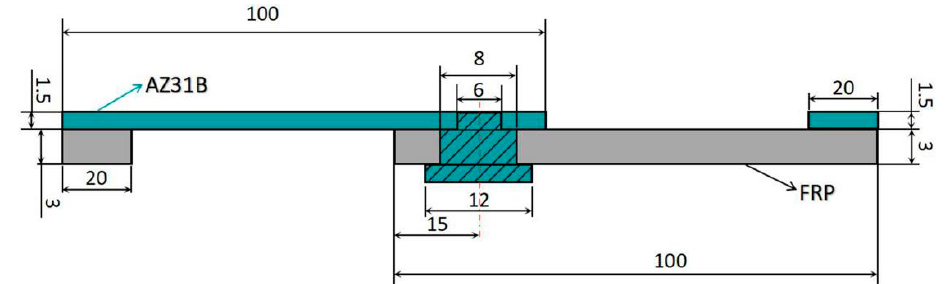
Figure 4. S chematic diagram of the specimen for tensile-shear testing (mm).